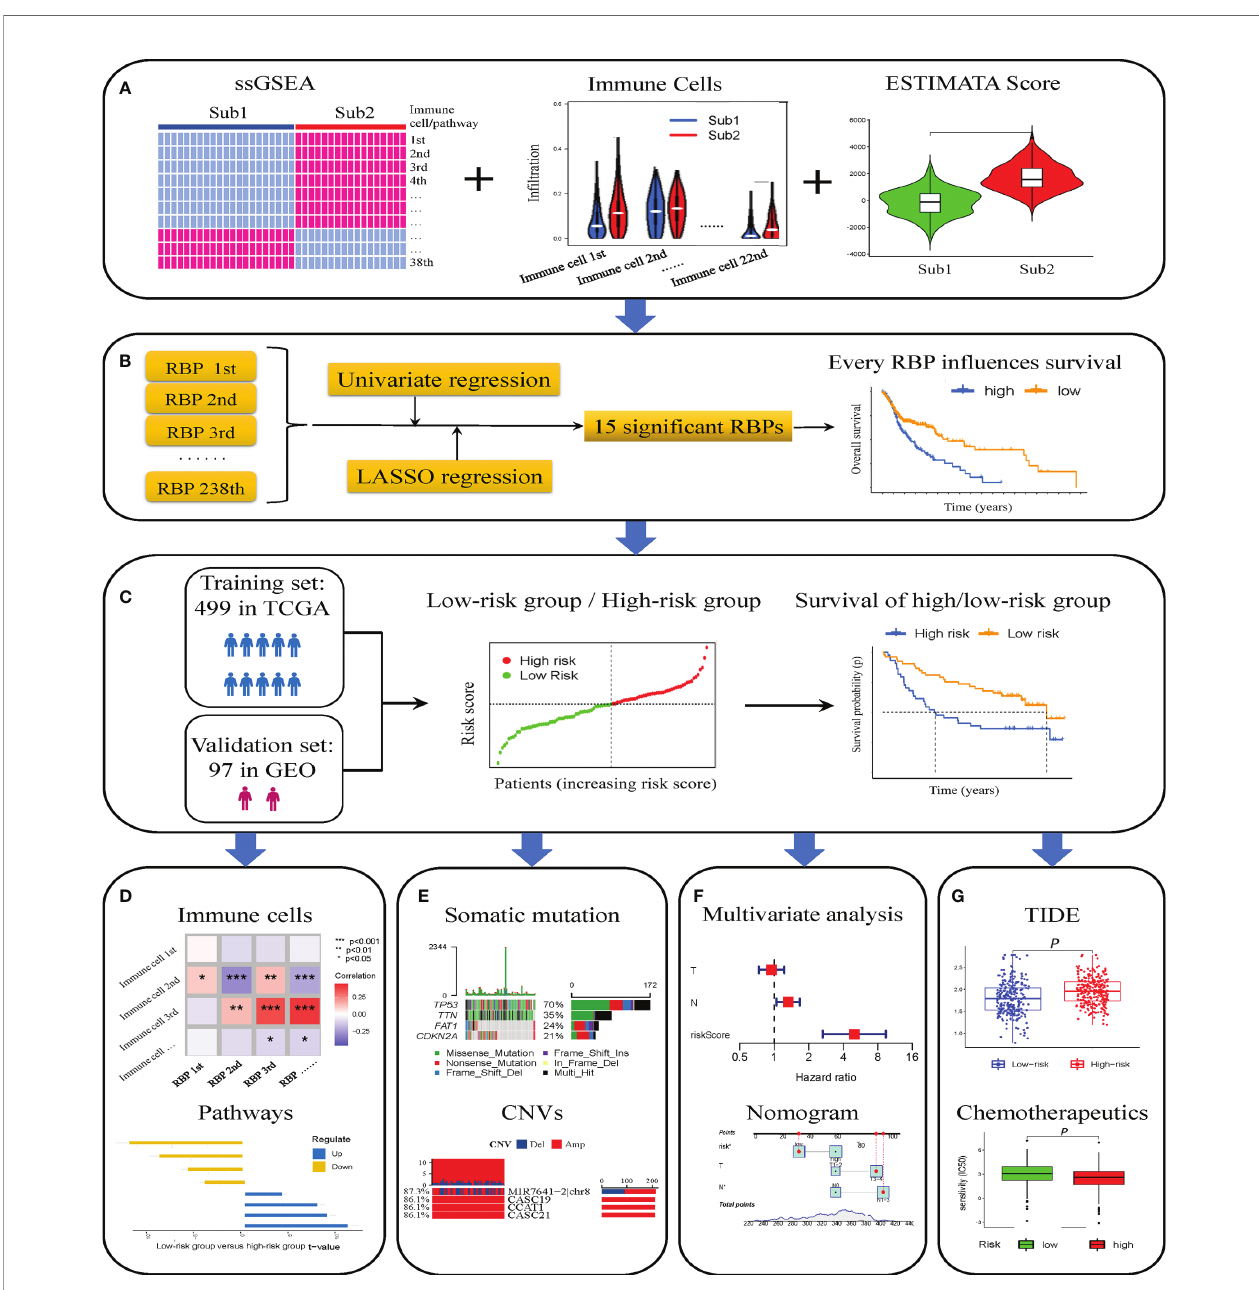
FIGURE 1 | Flowchart of this study. Two immune subtypes identi fi ed by single-sample gene set enrichment analysis (ssGSEA) and co-clustering analysis, and difference of in fi ltrating immune cells assessed by CIBERSORT deconvolution algorithm and ESTIMATE algorithm (A) . Fifteen immune-related RNA-binding proteins (RBPs) screened out through “ limma ” package, univariate and least absolute shrinkage and selection operator (LASSO) Cox analysis, and the Kaplan – Meier curves for high- and low-expression immune-related RBP groups (B) . Validation of the risk model composed of immune-related RBPs for prognosis in The Cancer Genome Atlas (TCGA) and Gene Expression Omnibus (GEO) database (C) . Immune cell in fi ltration and pathways in high- and low-risk groups (D) . Somatic mutation and copy number variations (CNVs) in high- and low-risk groups (E) . Construction and calibration of prognosis nomogram (F) . The differences of tumor immune dysfunction and exclusion (TIDE) score and sensitivity to chemotherapeutics of patients with head and neck squamous cell carcinoma (HNSCC) in high- and low-risk groups (G) . * p < 0.05; ** p < 0.01; *** p <